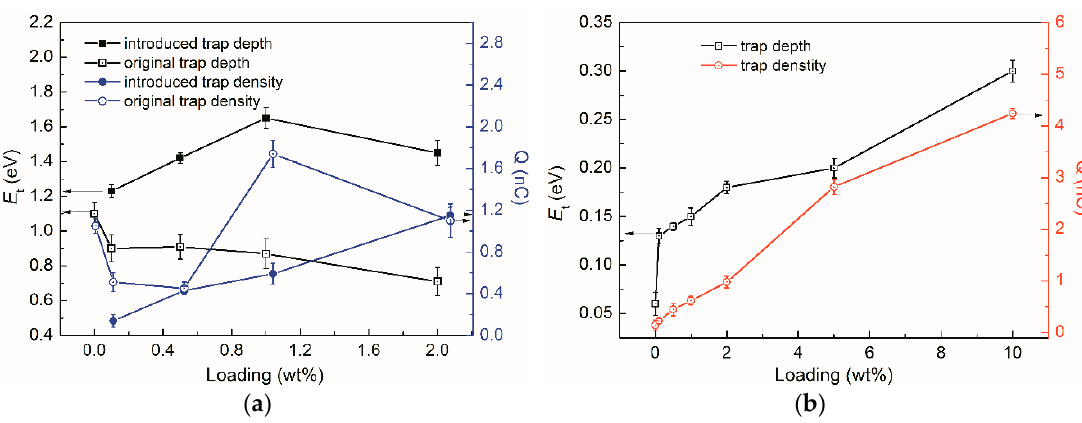
Figure 7. Trap information of LDPE/TiO 2 nanocomposites. ( a ) Deep traps; ( b ) shallow traps.